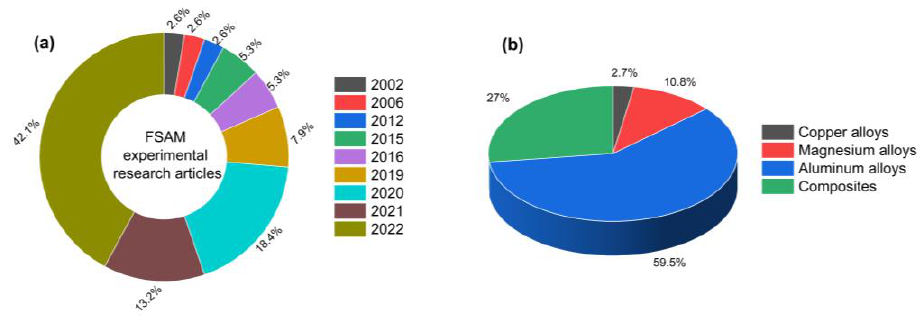
Figure 26. Academic research contribution in FSAM to date ( a ) publication yearly; ( b ) metallic alloy explored.